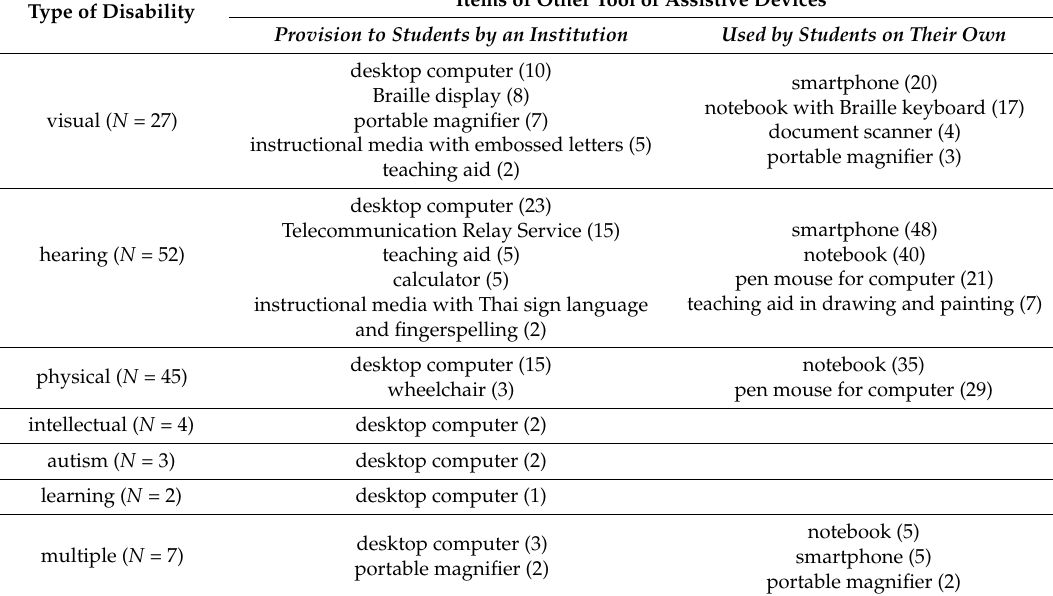
Table 4. Providing other tools or assistive devices that are not based on the universal design concept to students with disabilities.